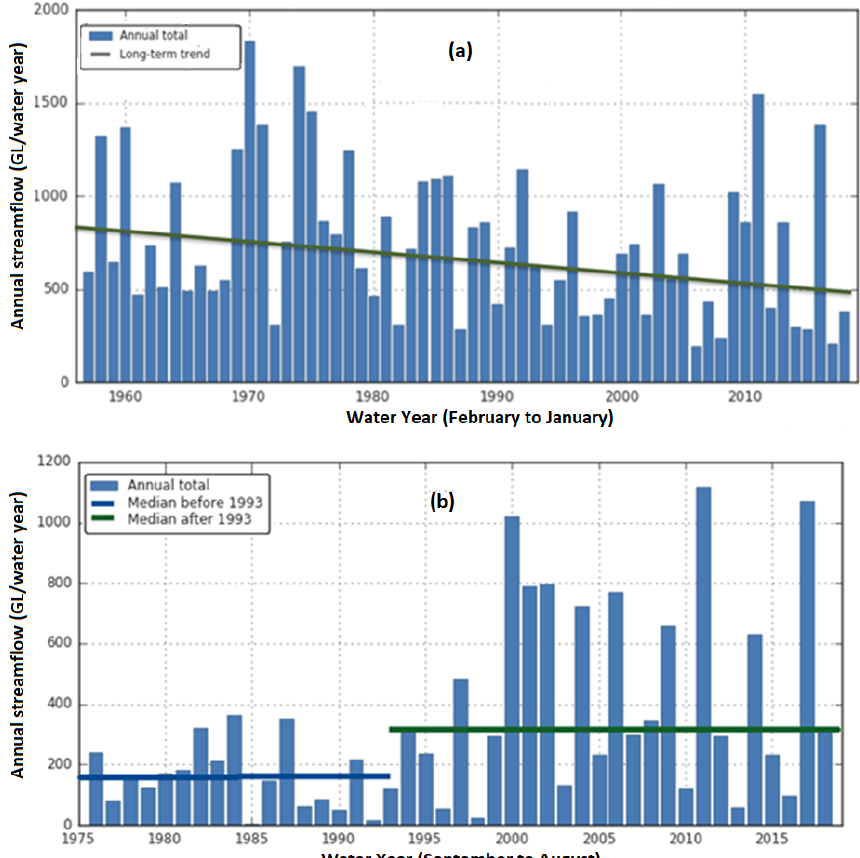
Figure 5. Typical examples of (a) trend and (b) step change in annual streamflow in southern and northern